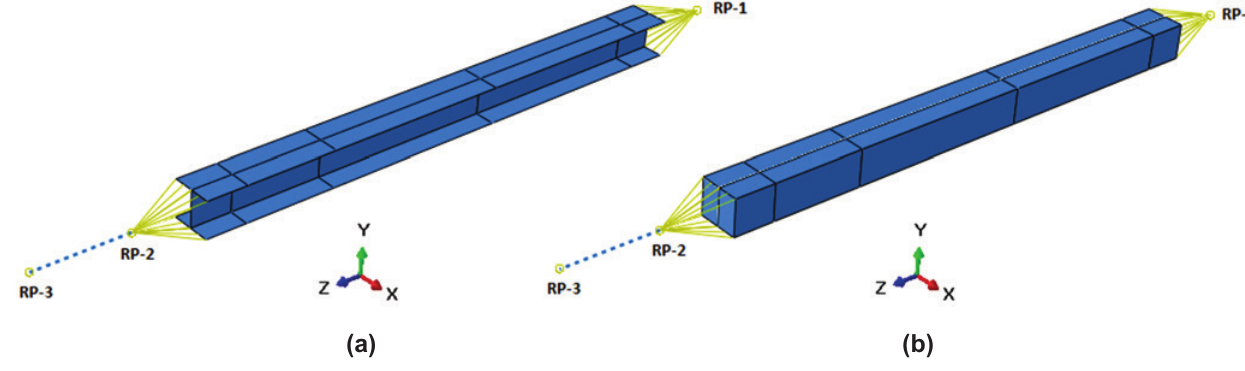
Pilares modelados: a) H220-ISO; b)